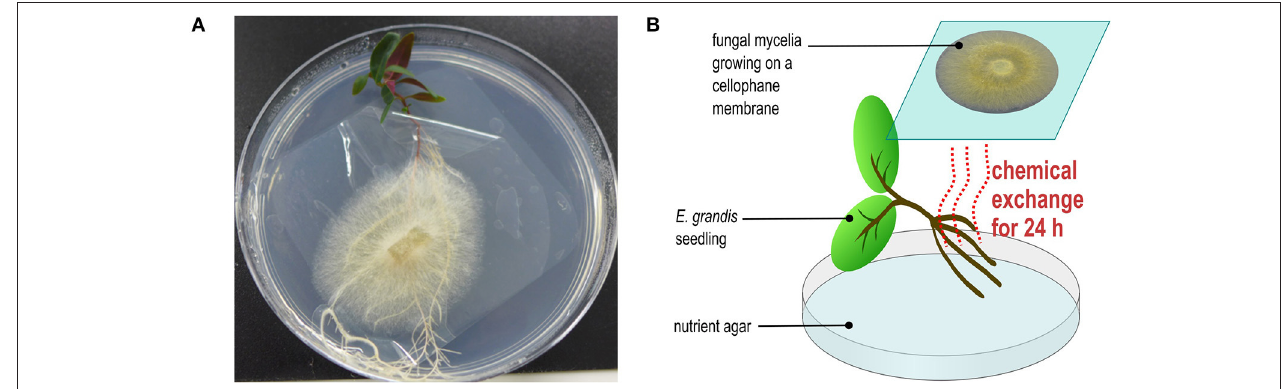
FIGURE 1 | Experimental microcosm used for this study (A) the picture demonstrated the experimental set-up for pre-symbiotic interaction between E. grandis and microbes. (B) The conceptual diagram explained the pre-symbiosis